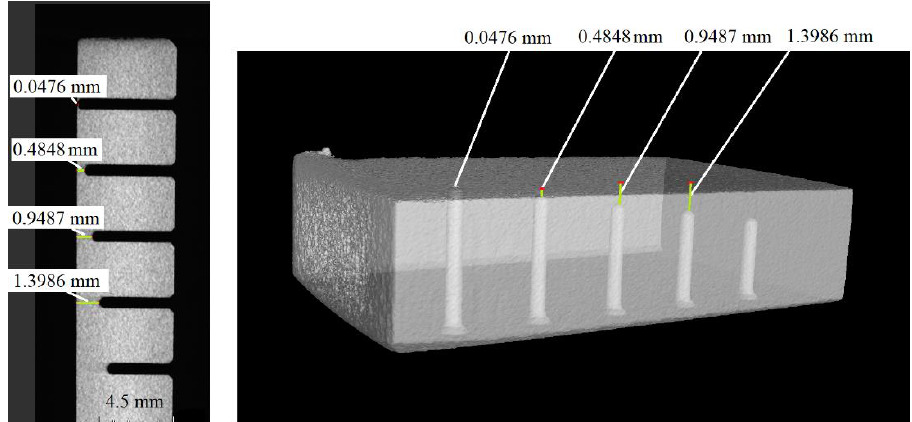
Figure 2. Locations of the thermocouples determined by VGStudio. Only the maximum temperatures registered by the thermocouples were considered. The data were used to calculate the theoretical temperature at the edge. The plot in Fig- ure 3 shows the relationship between the temperature and the distance from the edge.